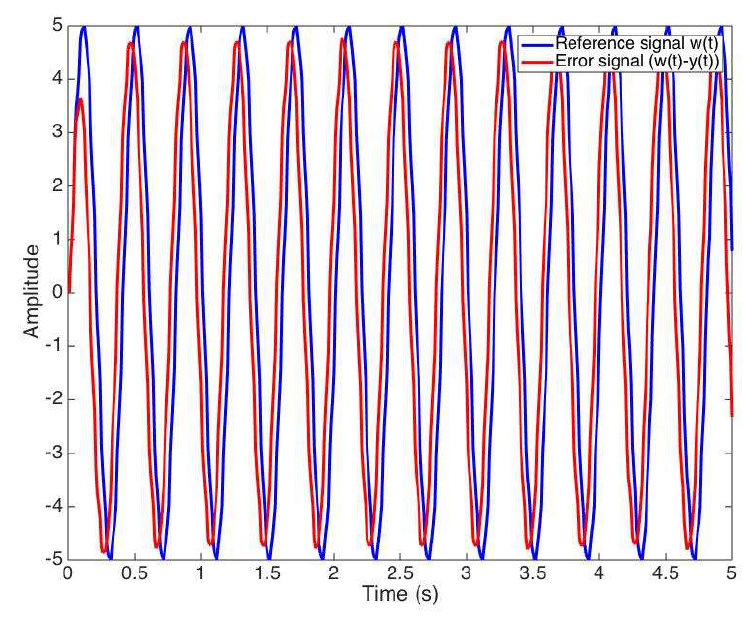
Figure 3. Signals used to determine the robot frequency response and the corresponding frequency response slope at the gain crossover frequency. Algorithms 2018 , 11 , x FOR PEER REVIEW